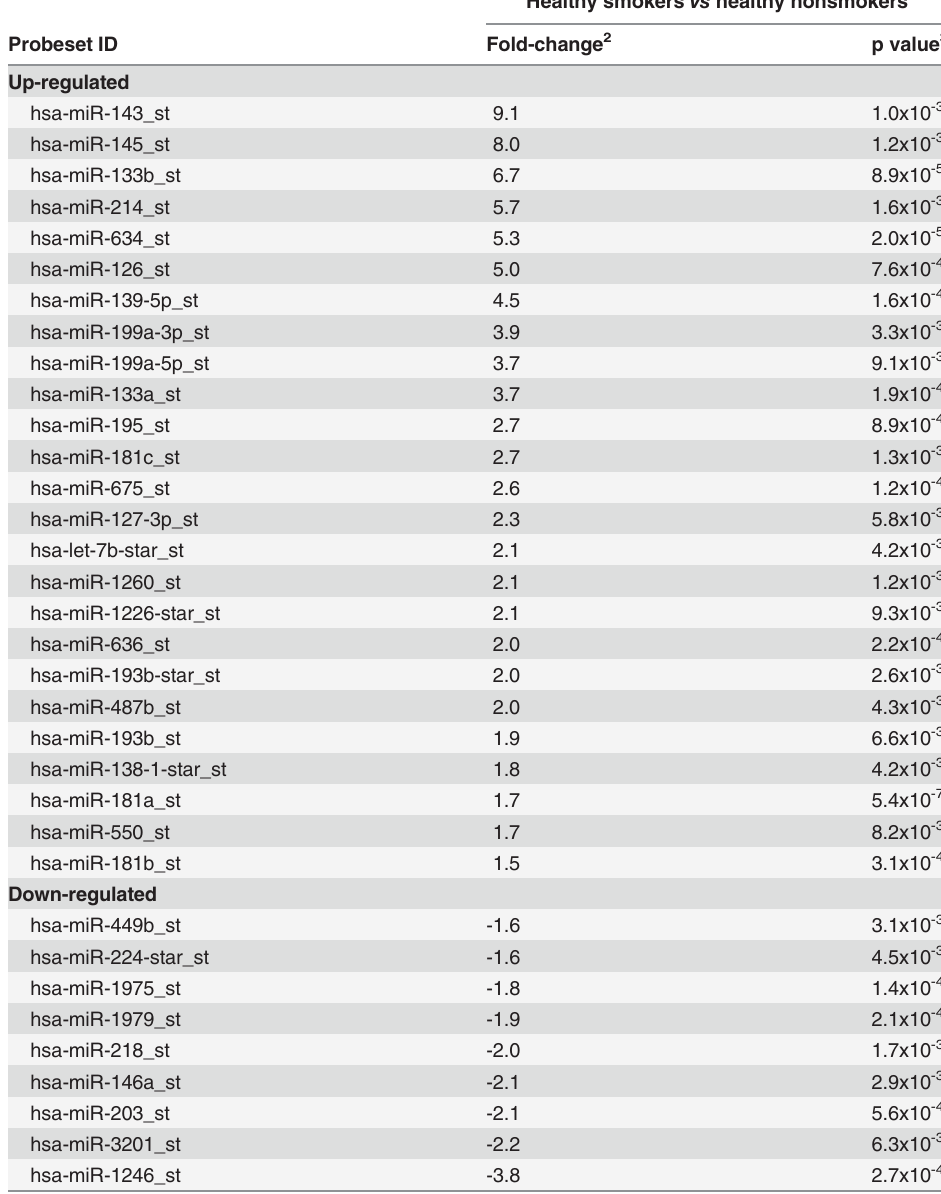
Healthy smokers vs healthy nonsmokers